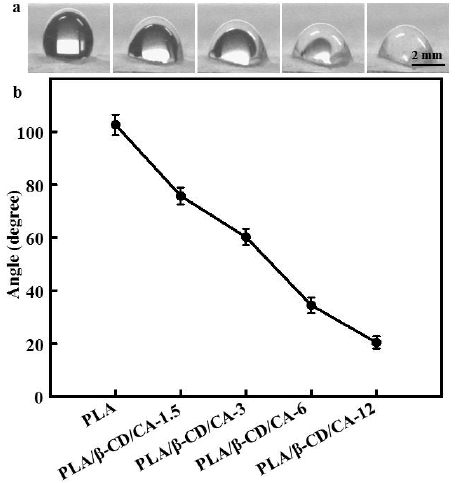
Figure 3. ( a ) Images of water contact angle of different fi bers; and ( b ) average water contact angles of the fi bers; n =